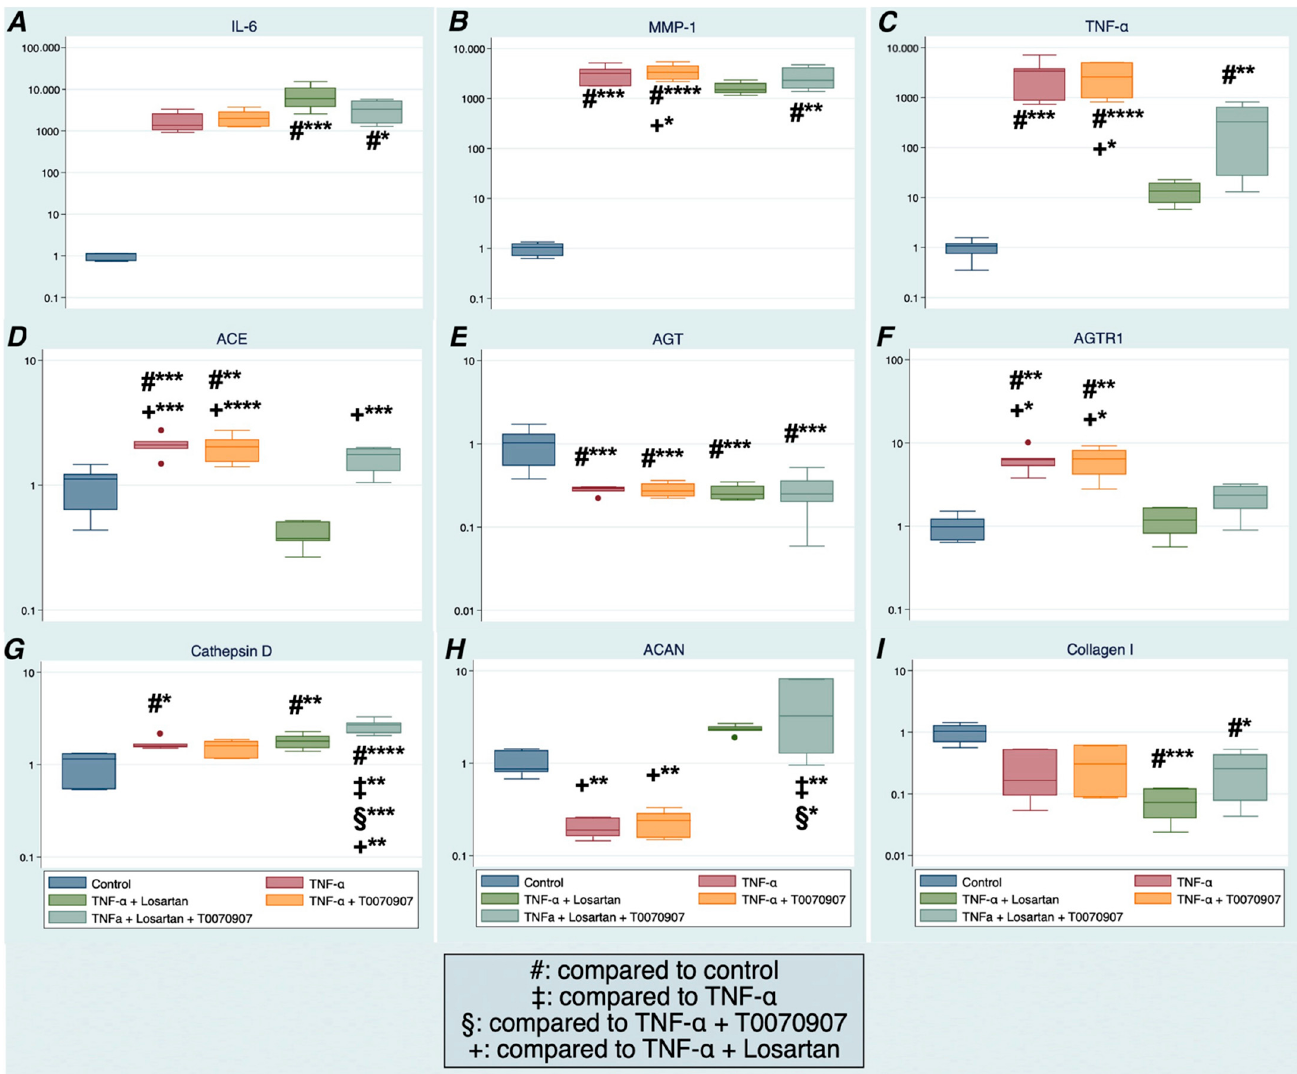
Figure 5. Influence of the PPAR γ pathway on losartan-induced gene expression changes of inflammatory and tissue degeneration markers ( A – C ), tRAS markers ( D – G ), and cell phenotype markers ( H , I ) in human NP cells after 72 h of exposure. Gene expression was normalized to Day 0 (baseline) values. Data from two donors assessed in triplicate are shown ( n = 6); * p < 0.05; ** p < 0.01; *** p < 0.001; **** p < 0.0001.